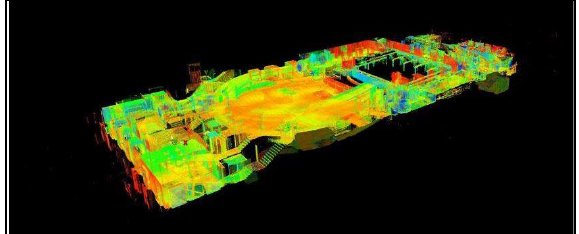
Figure 6. Point cloud section of the Lyric Theatre floor Source: : Municipality of Milan